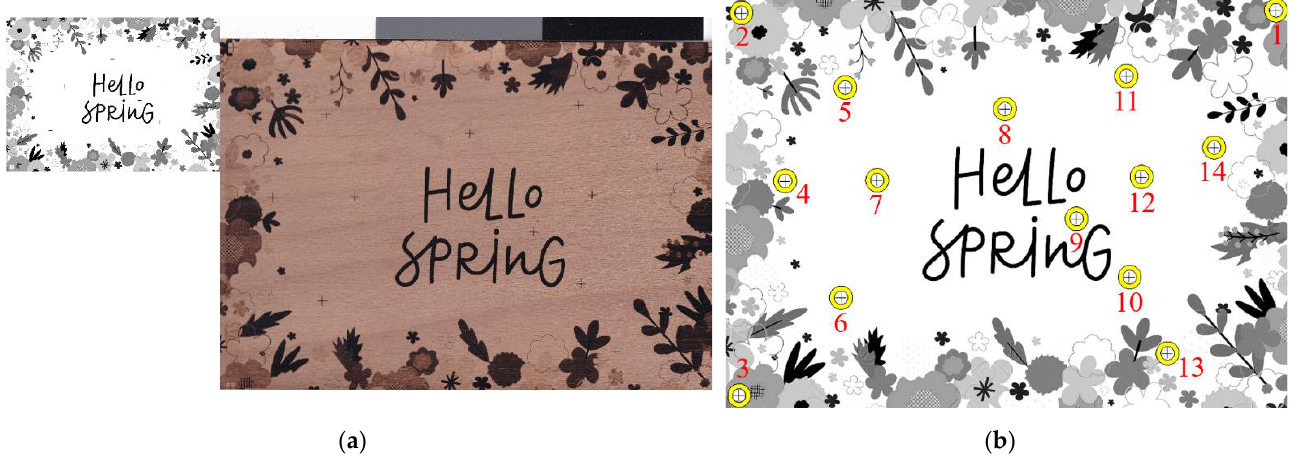
Figure 3. Source and scanned (laser-engraved) image: ( a ) From the left side source and scanned image preview; ( b ) Source image’s landmarks.